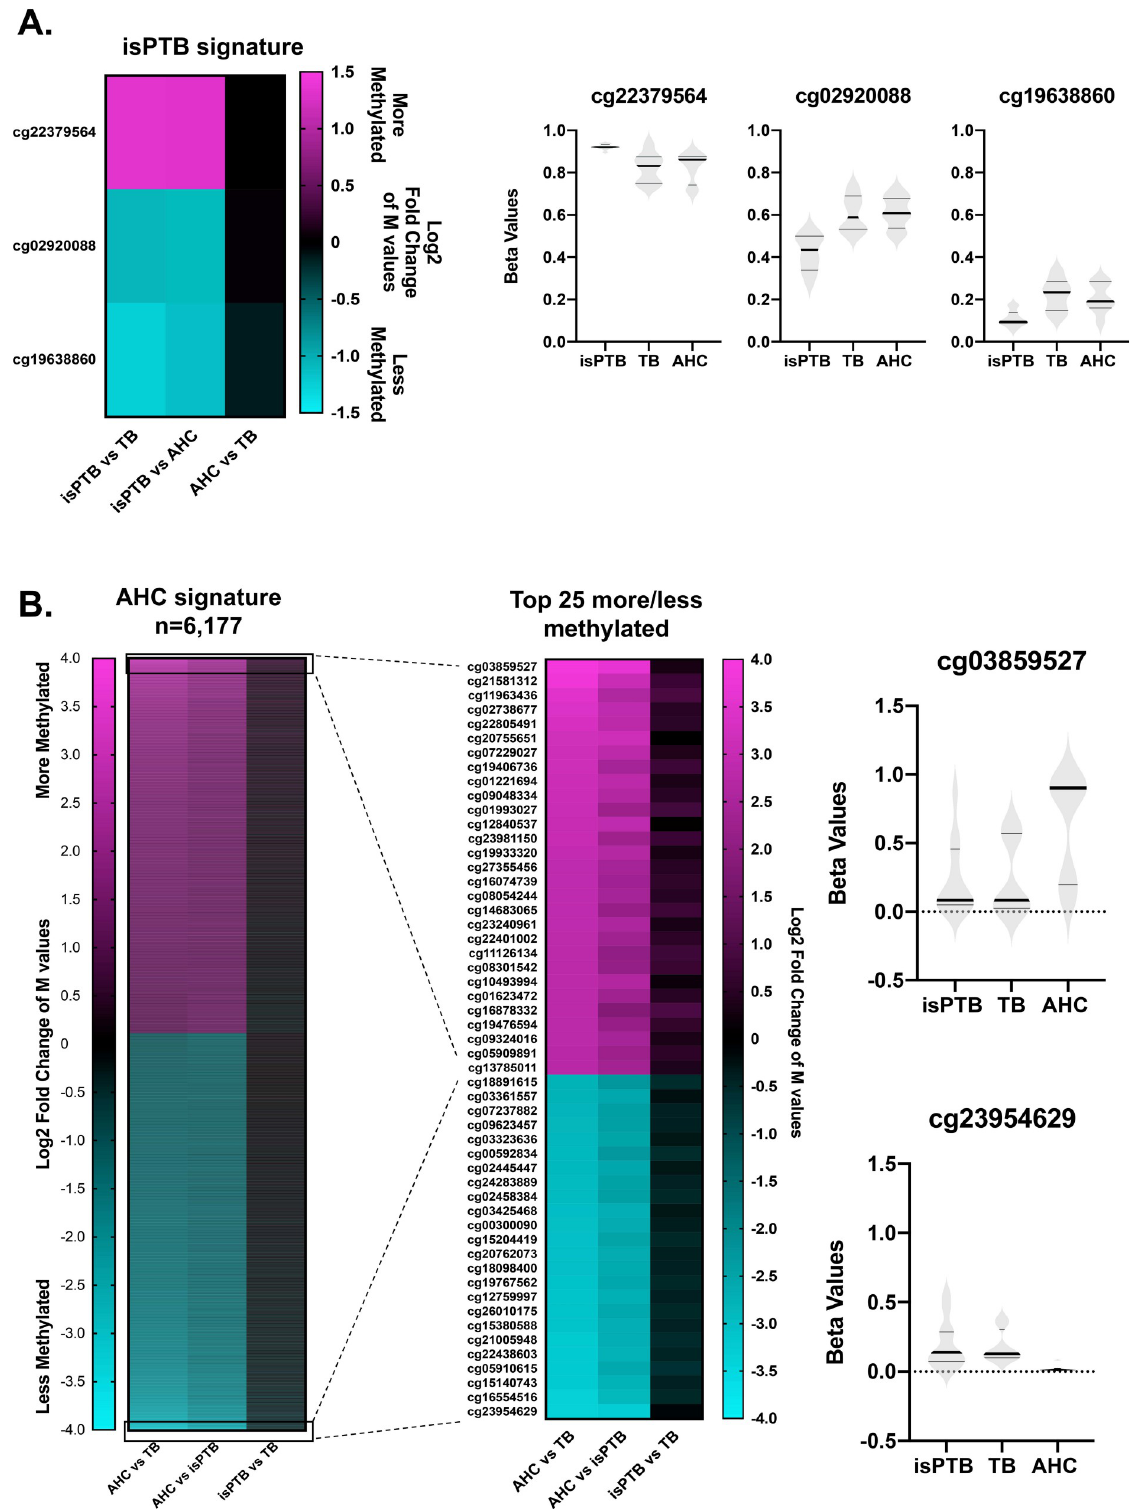
Fig 2. Identification of significant methylation profiles for isPTB and AHC DMPs. A. Three DMPs identified as having an isPTB specific methylation pattern where the isPTB samples were differentially methylated compared to the AHC or TB samples. The distribution of individual sample beta values was assessed to determine if there were outliers or artifacts influencing the methylation patterns. The dark